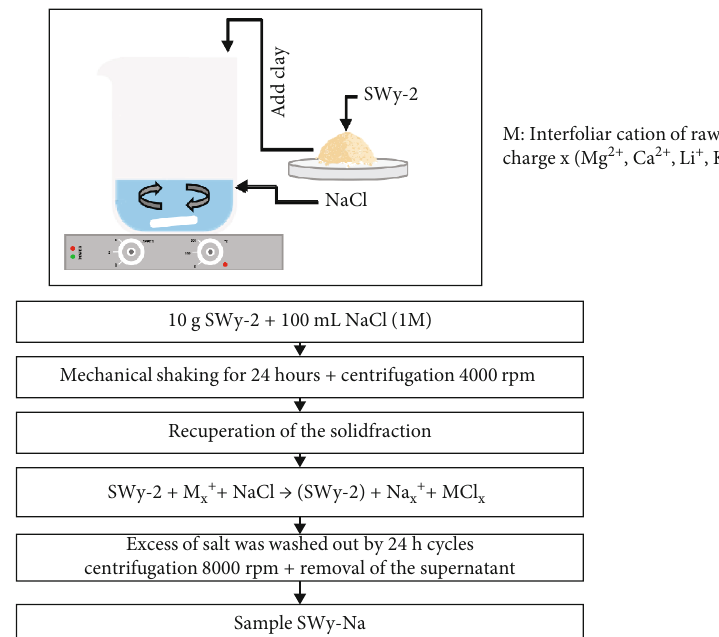
Figure 1: Experimental protocol for the puri fi cation of the starting material. Excess of salt was washed out by 24h cycles: centrifugation 8000rpm + removalof the supernatant .